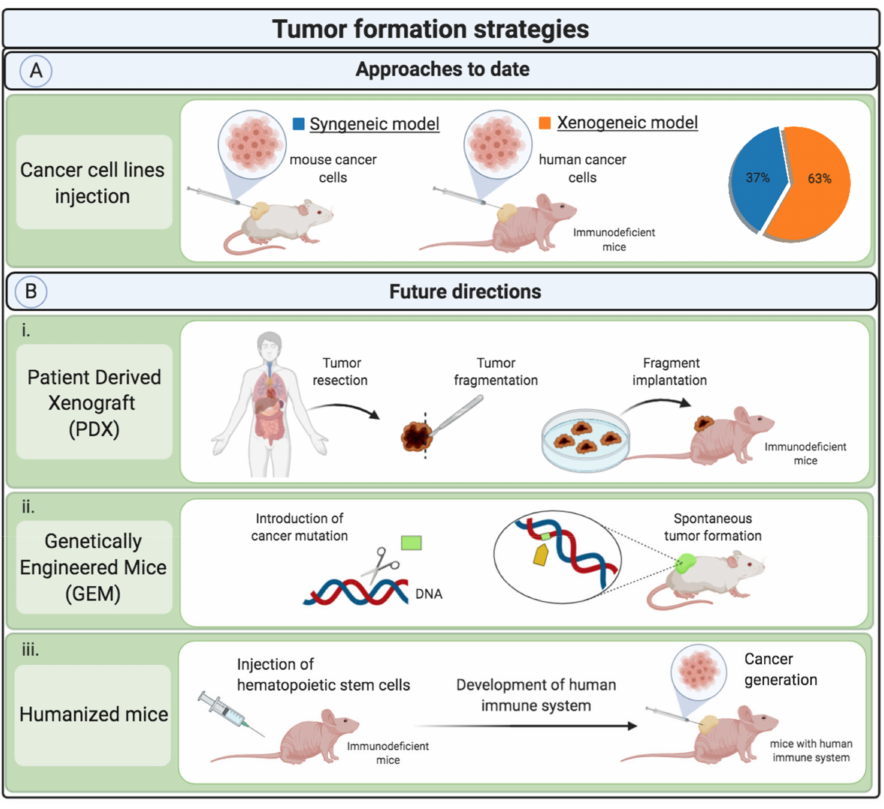
Figure 1. Tumor formation strategies on mice models for PCL treatments in vivo. ( A ) Current approaches assessed in the formation of tumors in animals for PCL treatments in vivo. ( B ) Possi- ble future directions in the generation of tumors in mice for the study of PCL treatments in vivo, which involve ( B.i ) patient derived xenografts, ( B.ii ) genetically engineered mice models, and ( B.iii ) humanized mice